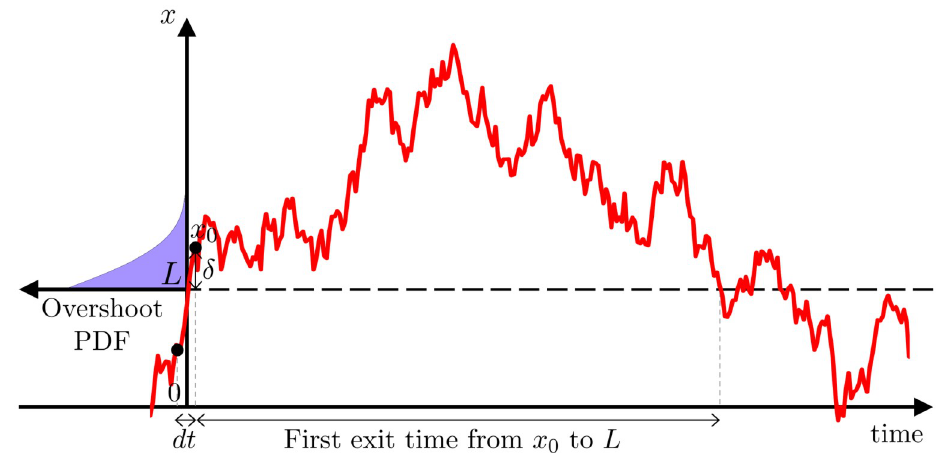
Fig 9. First exit time and overshoot distribution. Showing a discrete realisation of an OU process overshooting the threshold L by δ , with a sketch of the overshoot probability density at L in purple. The first exit time from x 0 to L is the time taken to get below L for the first time when starting from x 0 .